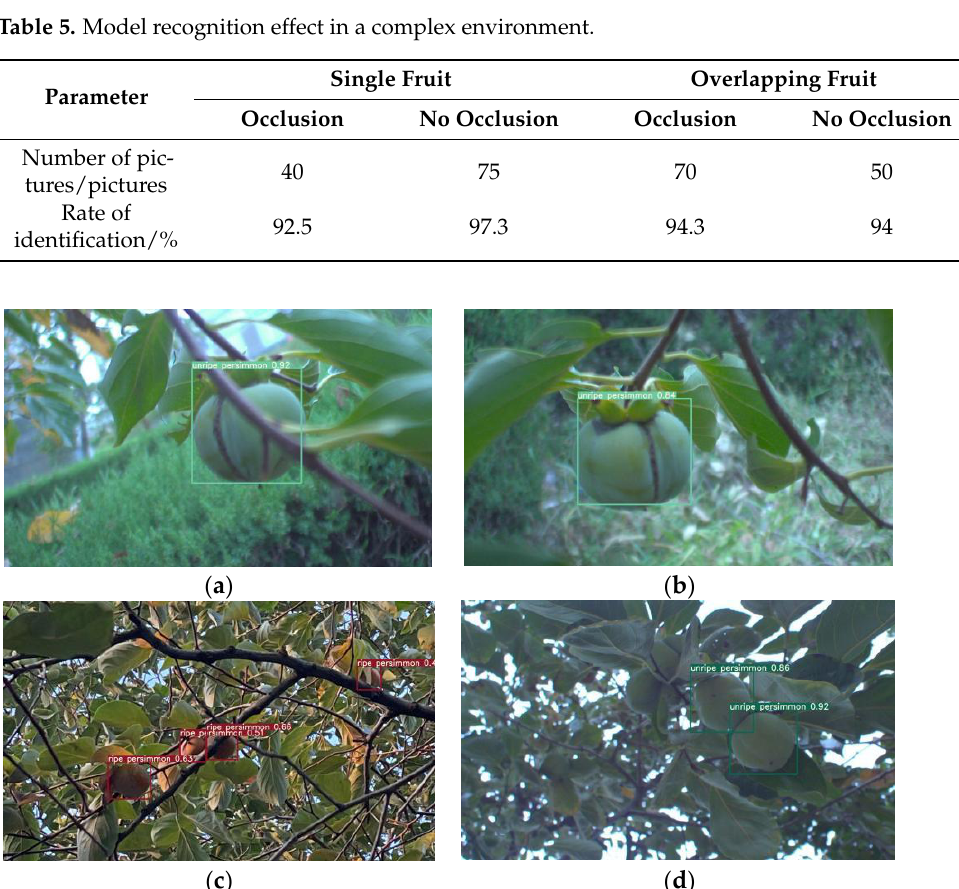
Figure 15. Results plot of single and overlapping fruit detection: ( a ) single fruit occlusion; ( b ) single fruit no occlusion; ( c ) overlapping fruit occlusion; and ( d ) overlapping fruit no occlusion.